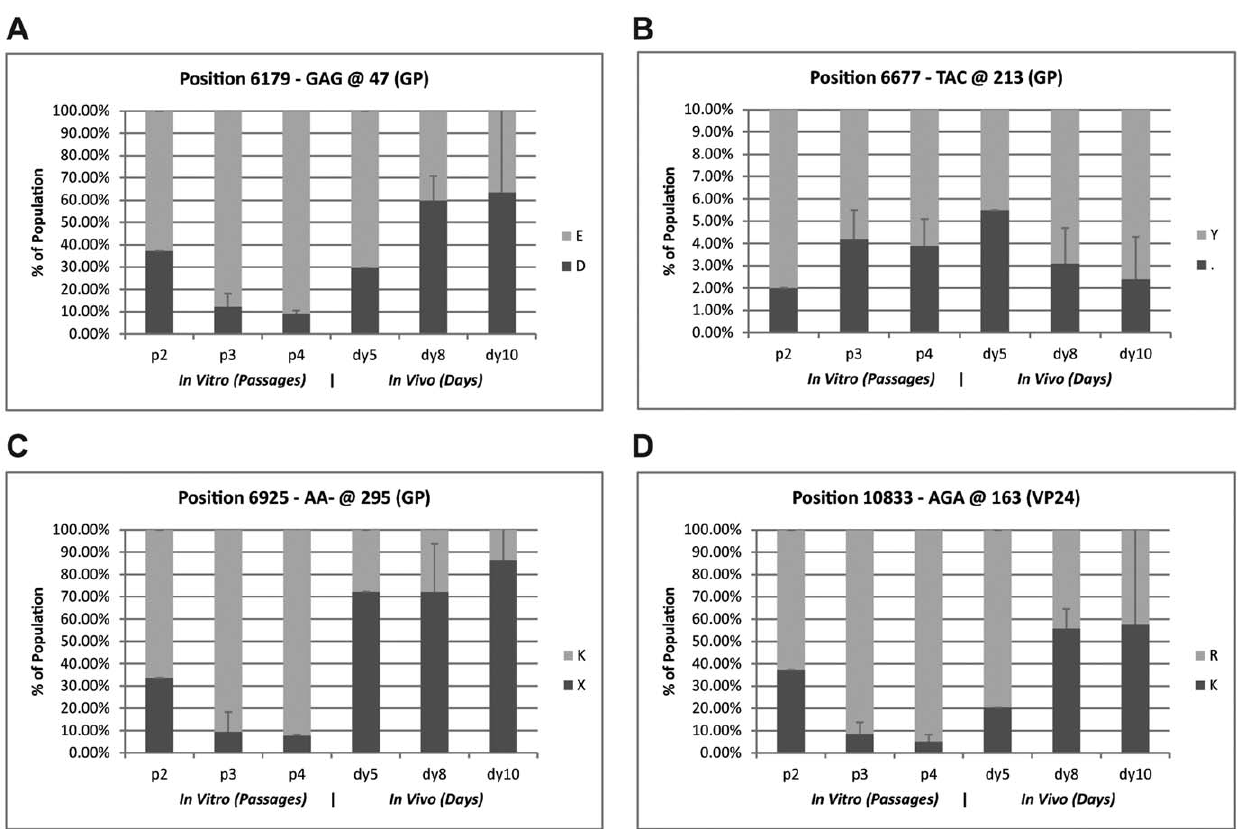
Figure 2. Comparison of EBOV-Kik invitro passage with invivo infection. EBOV-Kik samples from passage 2, 3, and 4 in Vero E6 cells (represent 1, 4 and 3 isolates respectively) were compared to six in vivo samples from lethally challenged crab-eating macaques collected after day 4. A passage 3 viral stock from this study (16502) was used as the challenge material for the in vivo samples. See Figure 1 for passage and seed stock information. Numbers are reported here as percent of population for sub-clonal variants. Error bars represent variance between multiple independently propagated lineages or infected animals (i.e. The data is summarized based on passage number or infection day rather than experimental or individual bounds). a) GP Poly-U transition. Here, we compare two variants of the 8U form that expressed predominantly the full length GP 1, and the 7U variant that predominantly expressed sGP. In vitro , we observed a dramatic and rapid shift between the 7U variant and the 8U variant at positions 6,925 and 6,926. By passage 3, there is an inversion in variant levels and there is an equally rapid reversion observed by day 8 in vivo . b) Stop Codon detection. There is a twofold increase in the amount of the sub-clonal variant encoding for a truncated form of GP 1,2 at position 6,677.* Note: the scale is changed to 10% for better visualization. c) and d). Marker increase in vivo . We identify two changes 6,179, and 10,833, which result in amino acid changes 2 protein in GP 1,2 and VP24 respectively. As with the 7U variant, the subclonal variants at these positions decrease and revert rapidly when switching between cell culture passage and